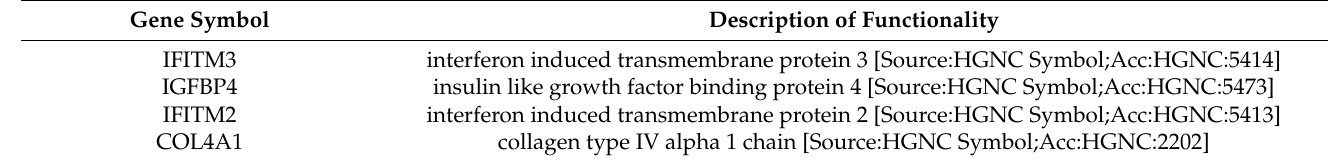
Table 4. List of 9 out of 20 overlapped genes between our top 20 ranked genes and pancreas gene sets